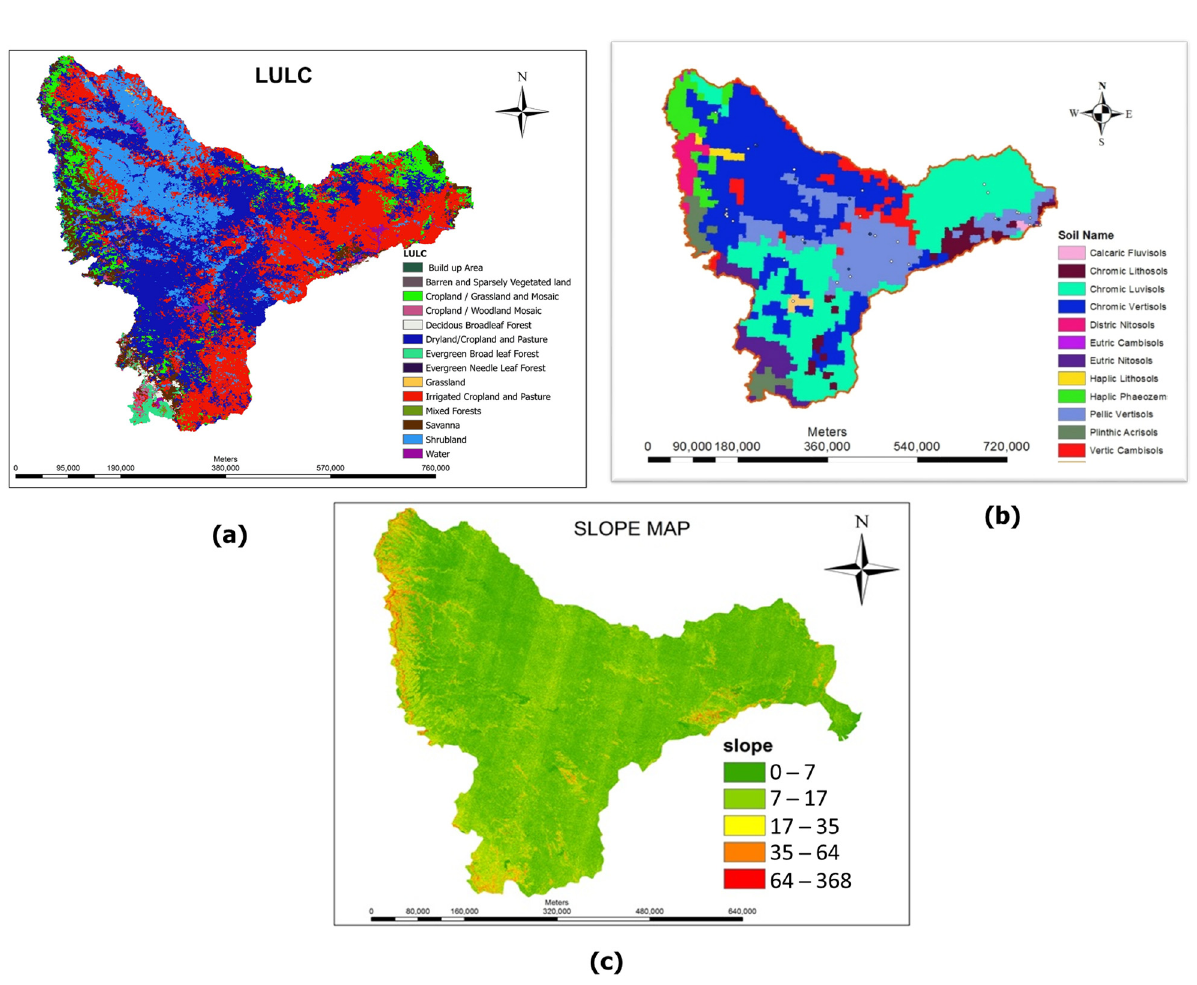
Figure 2. Thematic maps of the Krishna basin ( a ) Land use/Land cover, ( b ) Soil and ( c ) Slope. Based on the availability of data, spatial and temporal variations in climate parameters and streamflow are analyzed without considering any man-made structures, such as dams, diversions, etc. The climate model data obtained from five RCMs as mentioned in Table 2 under the representative concentration pathways (RCP) 4.5 scenario and RCP 8.5 scenario are used with the assumption that emissions will be reduced by the end of the